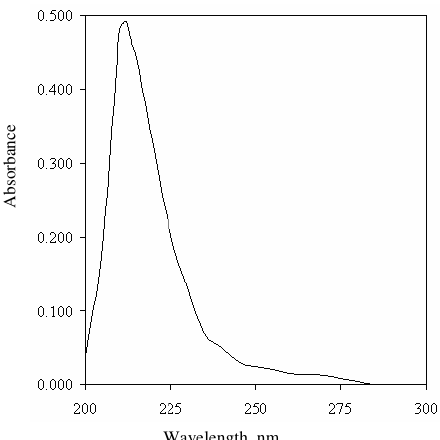
Figure 2b. Spectrum changes of m -CBA with time [ o -CBA] = 5.0 x 10 -5 M, [2-Naphthol] = 5.0 x 10 -5 M, light intensity= 11.8 x 10 -8 E sec -1 , pH= 11.5, Temperature= 298 K